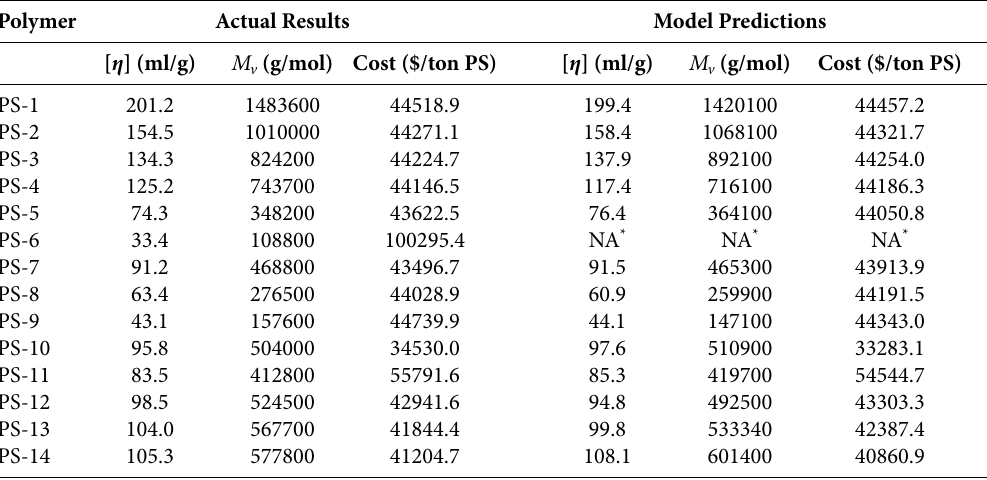
Table 3. Molecular weight of synthesized polymers, and cost-molecular weight relationship.